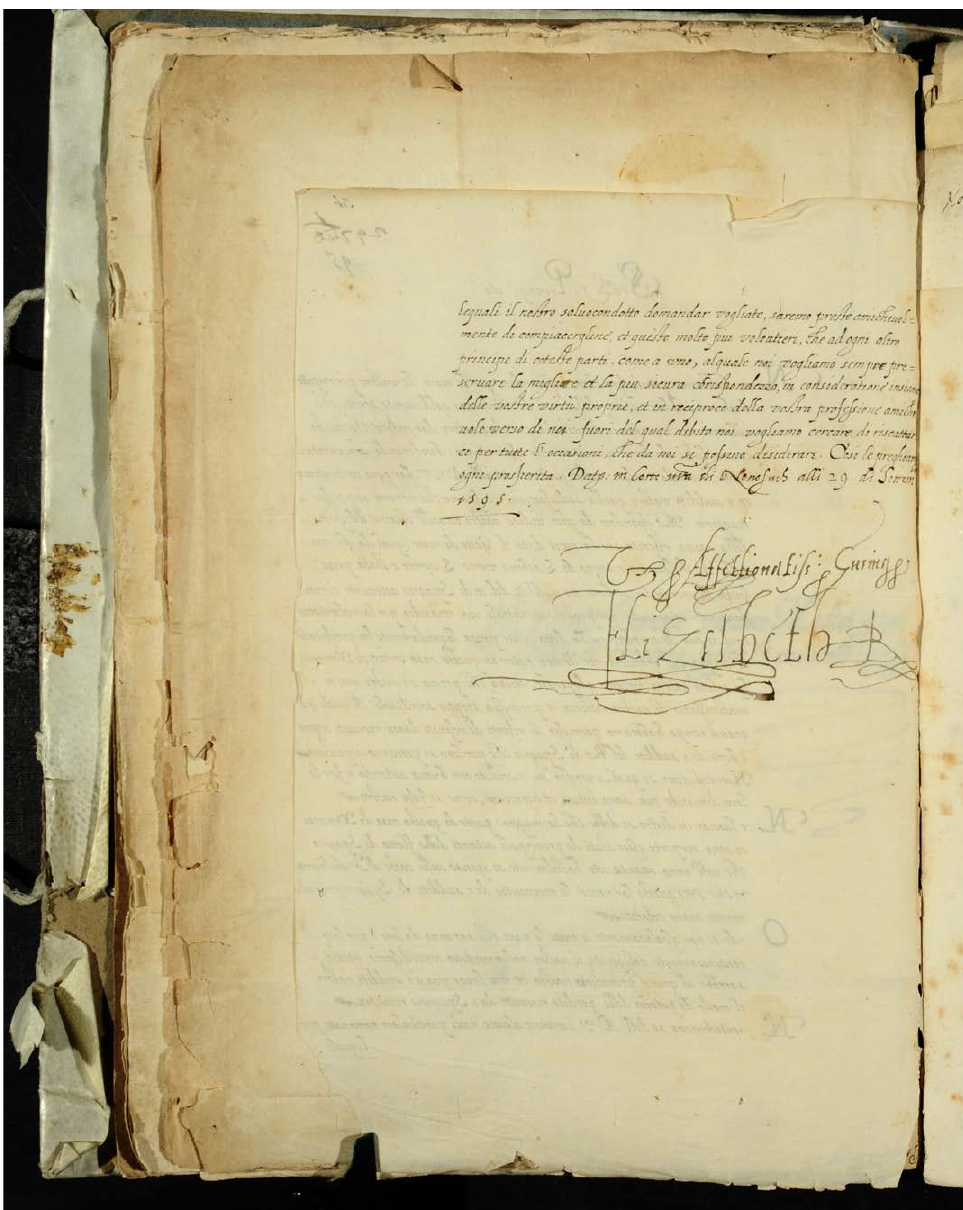
Fig. 4b – Letter to Ferdinando I of Tuscany penned by scribe ‘B’ (verso, showing Elizabeth’s